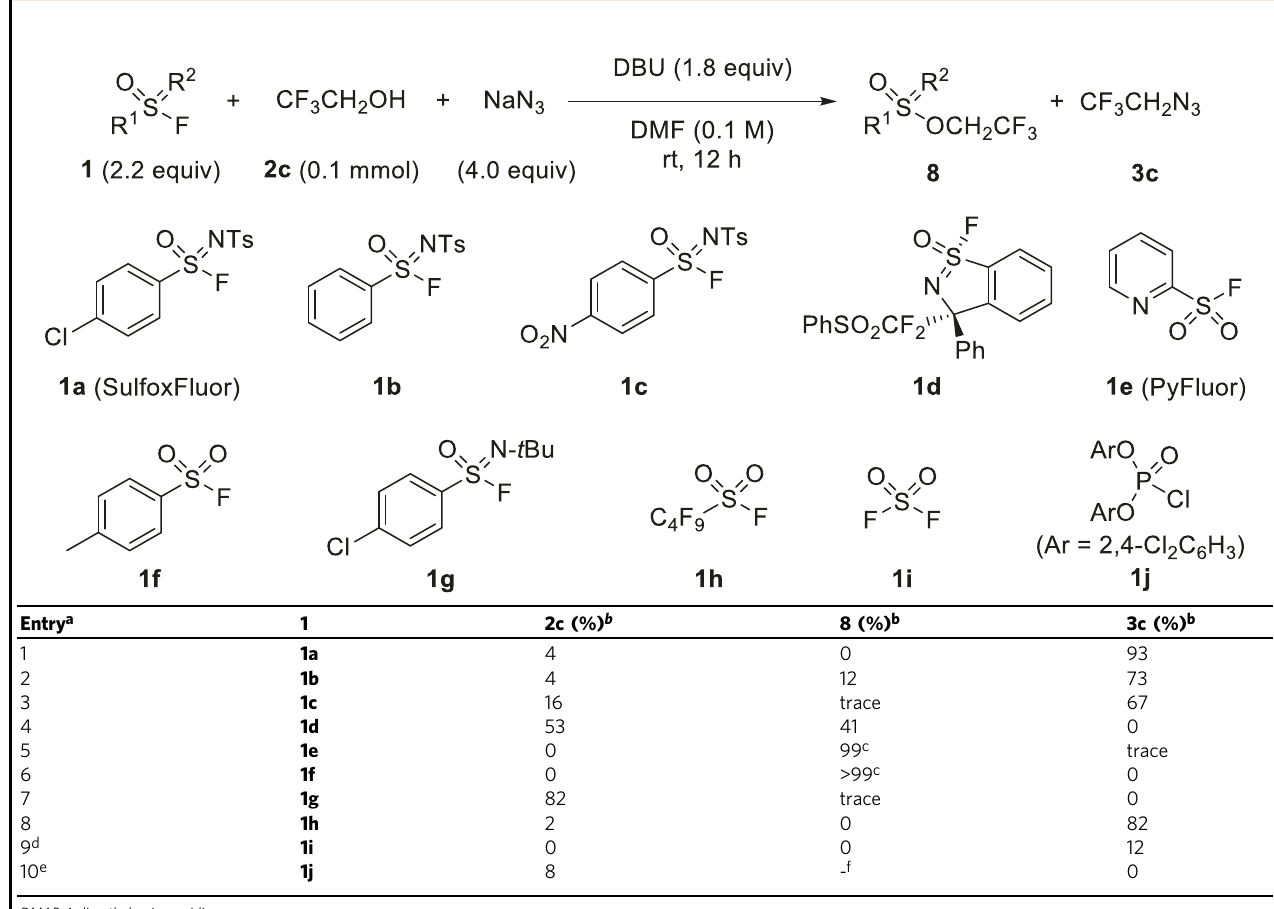
Table 3 Azidation of CF 3 CH 2 OH with sulfonyl fl uorides and sulfonimidoyl fl